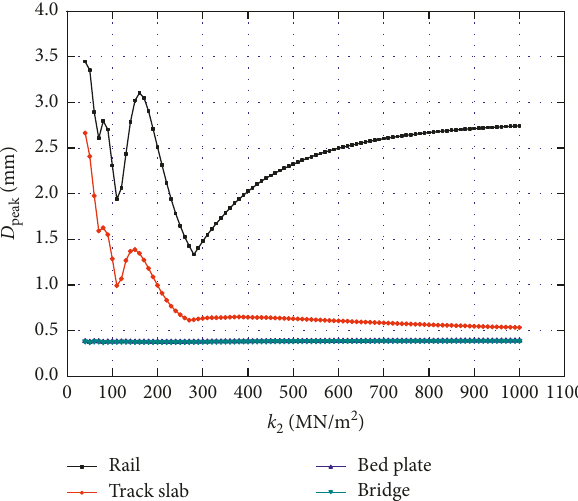
Figure 7: The maximum dynamic deflections of the rail, track plate, base plate, and bridge corresponding to different stiffnesses of the rubber pad under the supporting block.